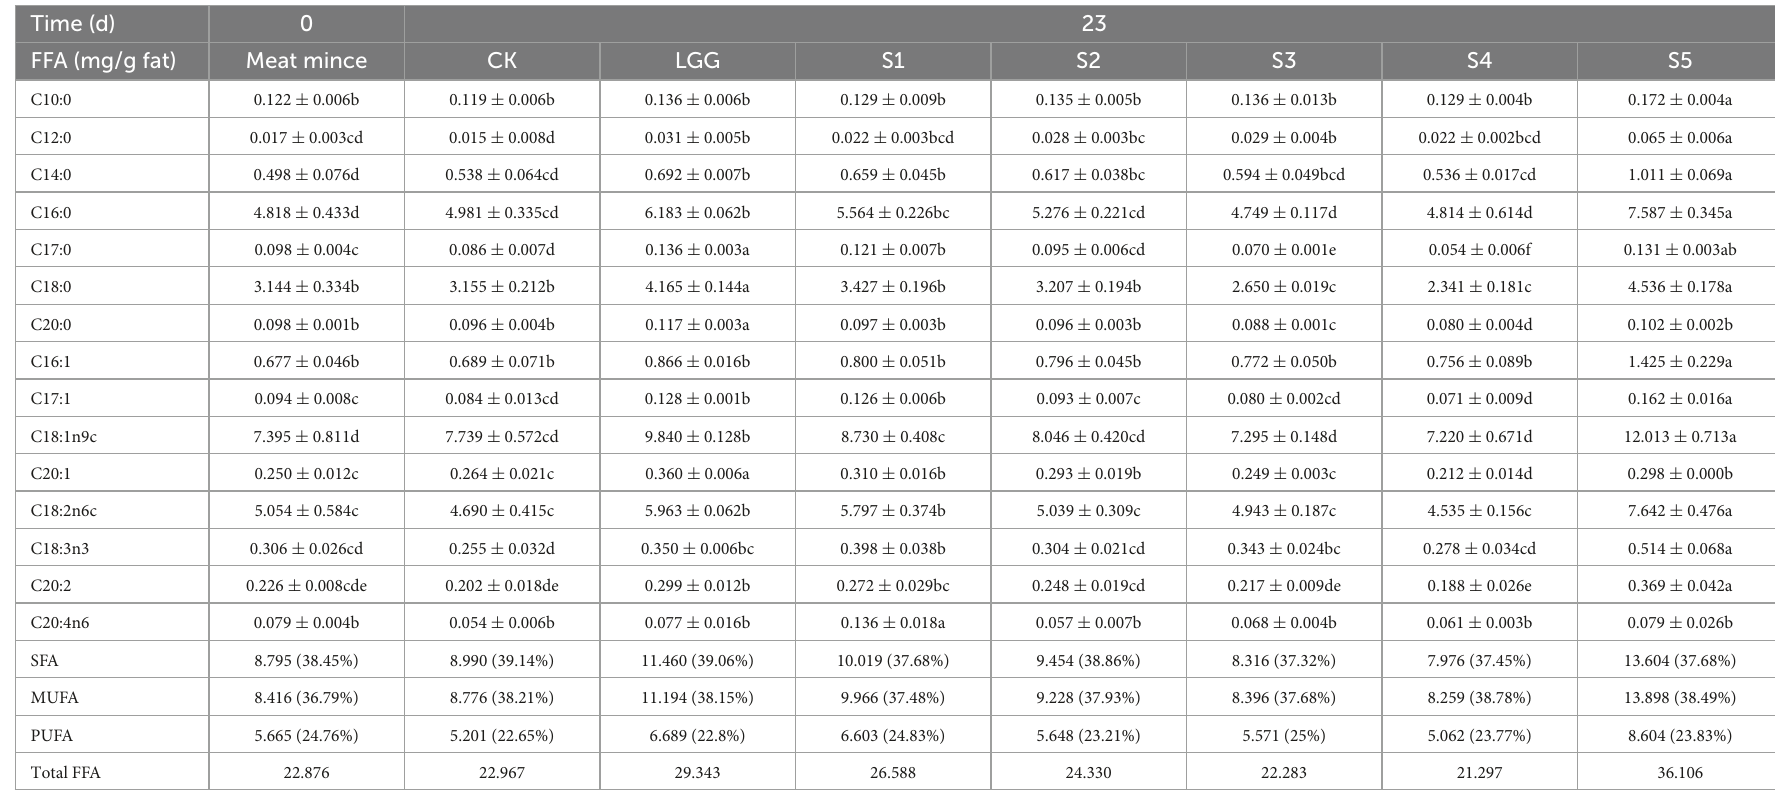
Values in brackets of SFA, MUFA, and PUFA indicate the proportion of such fatty acids in total free fatty acids (%). Different lower case letters indicate that there is a significant difference in the content of this fatty acid between different groups of fermented sausages ( p <